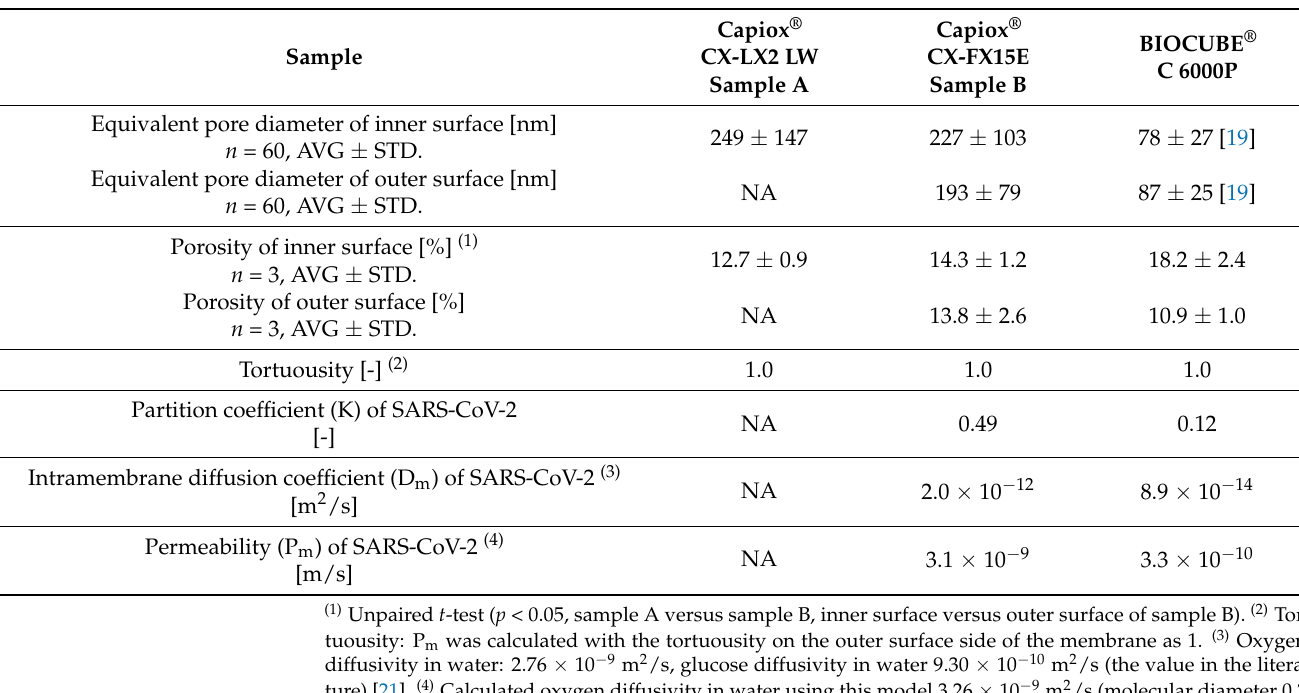
Table 2. Equivalent pore diameter of ECMO membranes and SARS-CoV-2 permeability.